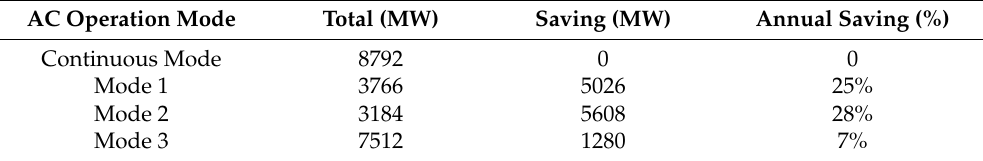
Table 12. The total peak power and saving of all houses types for the whole of